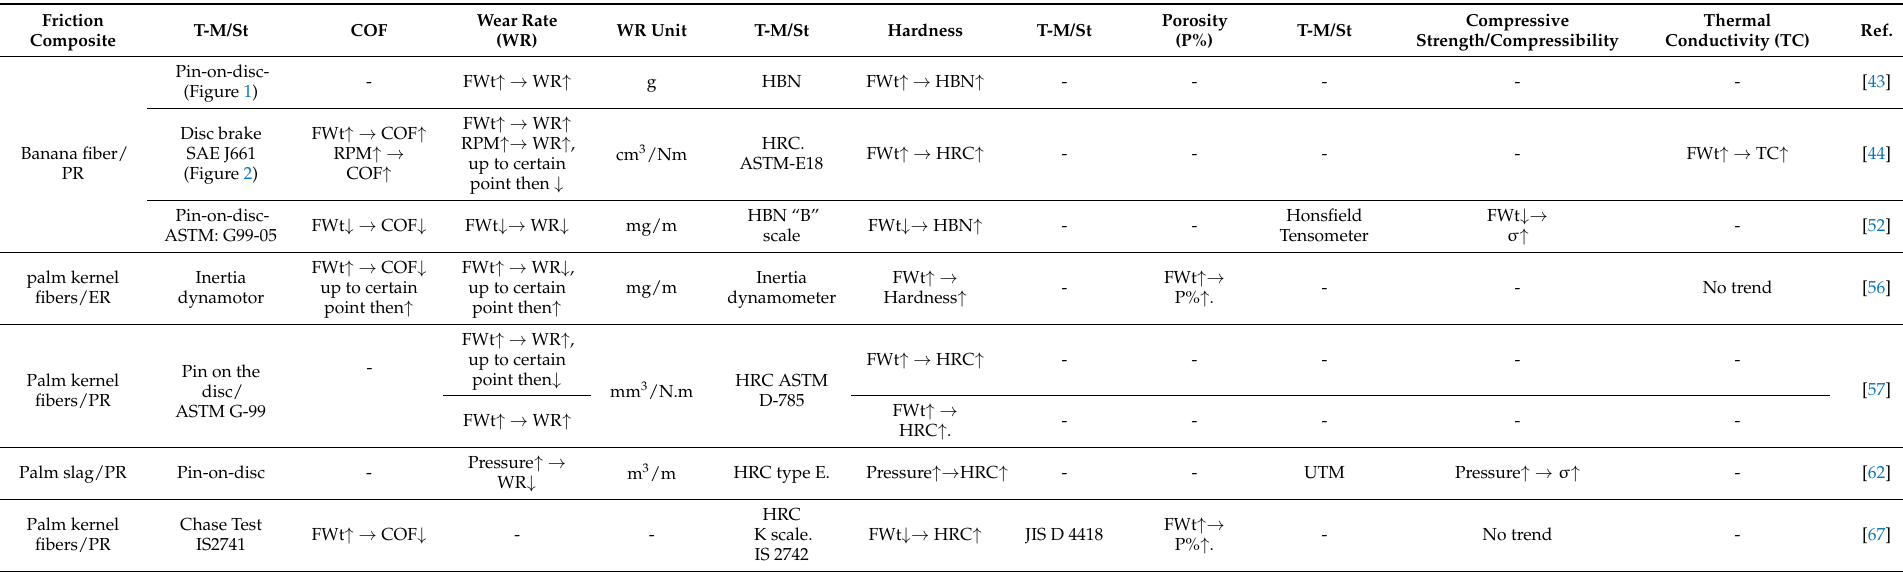
Table 3. Illustrates the effect of natural fiber on tribological and mechanical properties of braking pads